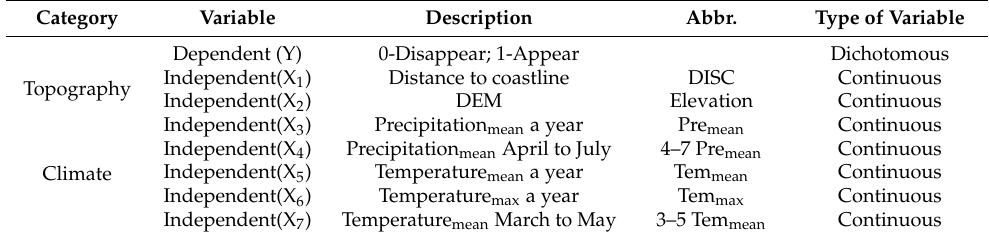
Table 1. List of the variables included in the logistic